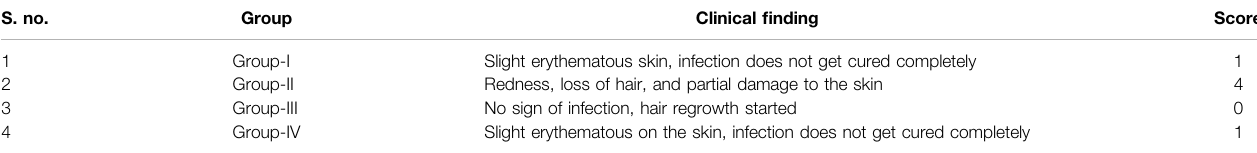
TABLE 8 | In vivo investigation of gel preparations and clinical fi ndings. S.